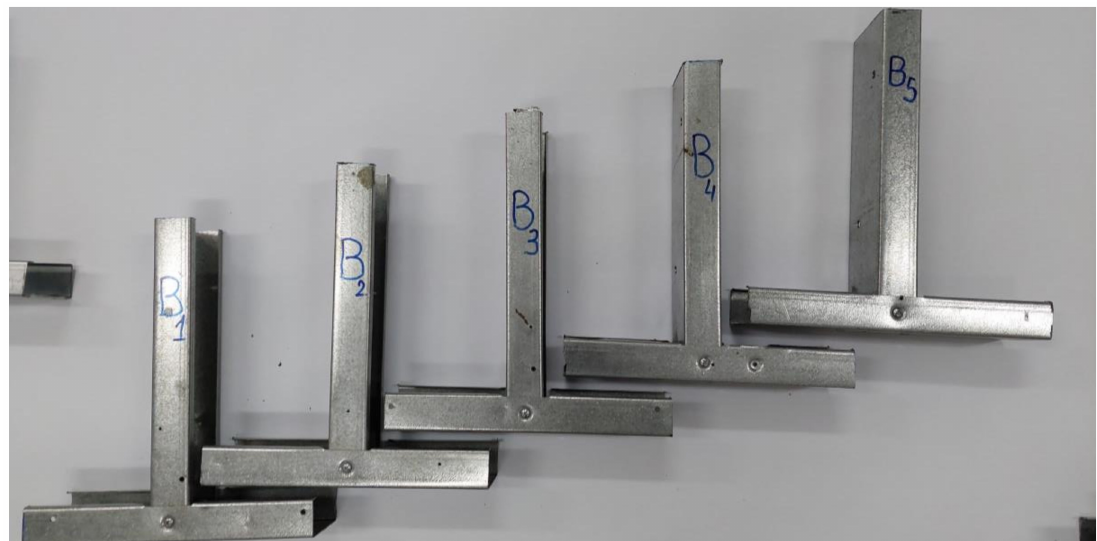
Figure 8. Specimens for B